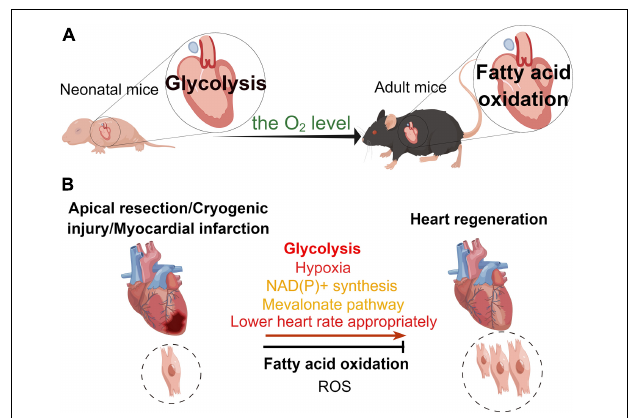
FIGURE 2 | Different metabolic patterns in physiological and pathological states affect the myocardial regenerative capacity. (A) Under physiological conditions, the main mode of metabolism in the murine neonatal heart is glycolysis, whereas that in the hearts of adult mice is fatty acid oxidation. (B) In the pathological state, glycolysis, hypoxia, NAD(P)+ synthesis, mevalonate pathway, and appropriate reduction in heart rate promote heart regeneration, while fatty acid oxidation and reactive oxygen species (ROS) inhibit myocardial regeneration in the neonatal mouse heart regeneration models (apical resection, cryoinjury, or myocardial